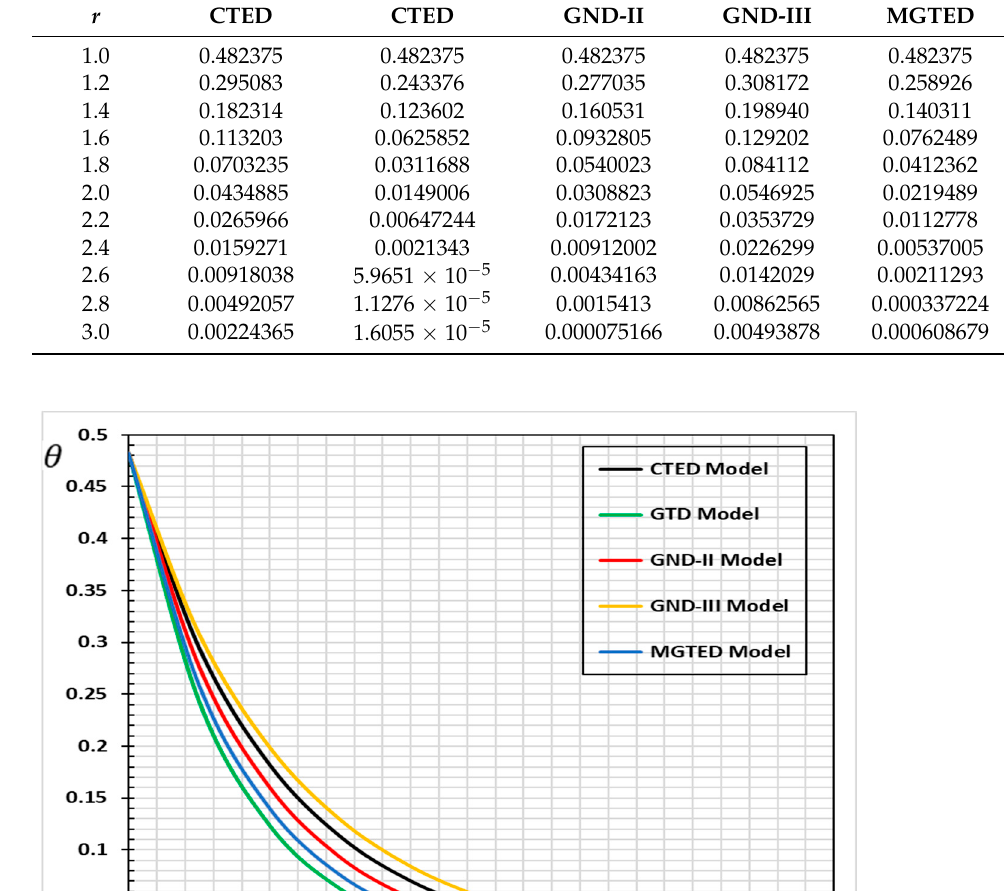
Table 1. The temperature 𝜃 for different thermo-diffusion models.